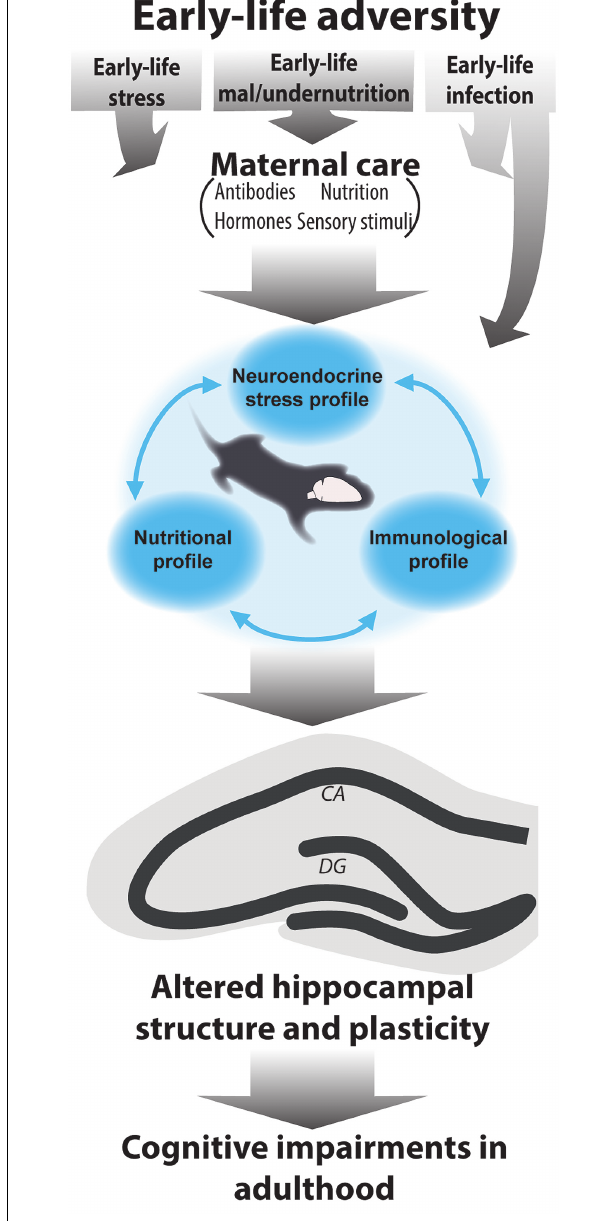
FIGURE 1 | Schematic representation of the interrelated role of different early-life elements for the consequences of early-life adversity. Early-life adversities in the form of early-life stress, under/malnutrition and infection are known to modulate hippocampal development and altogether determine hippocampal structure and function in adulthood with adverse effects on learning and memory. During the early sensitive period of development the offspring is fully dependent on the mother. Maternal care encompasses several elements (sensory stimuli, transfer of nutrition, hormones, and antibodies). In fact it is mostly via disruption of maternal care (with exception of early-life infection which can directly act upon the offspring) that early adversities will elicit disruptions in hormonal, (neuro)inflammatory and nutritional profiles in the offspring. Because these elements affect one another, they will ultimately act synergistically to modulate hippocampal structure and function throughout